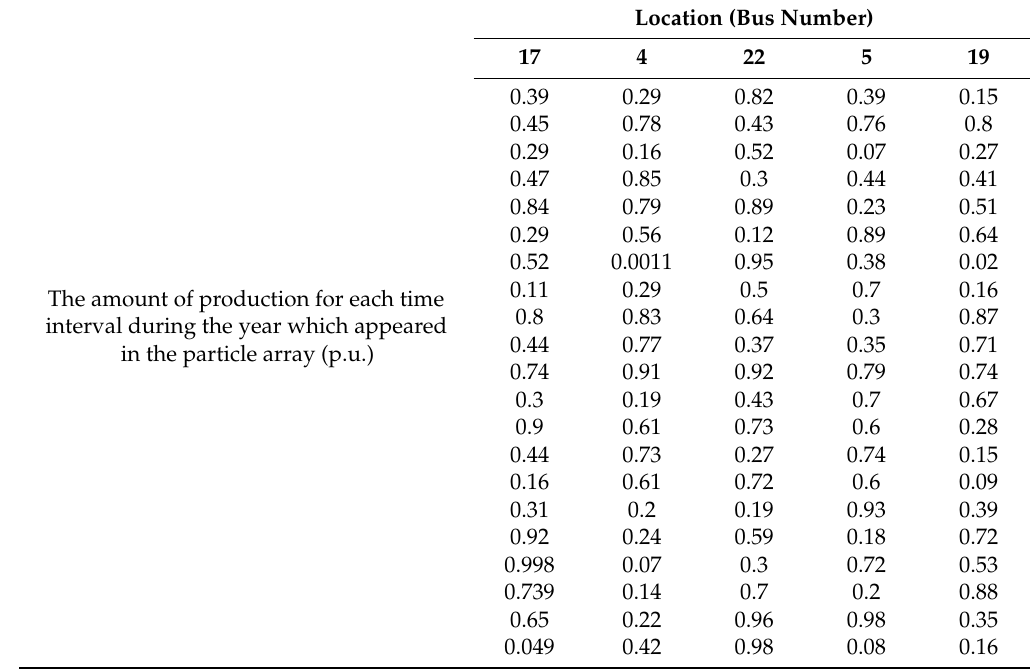
Table 4. Optimum power generation profile and the location of the